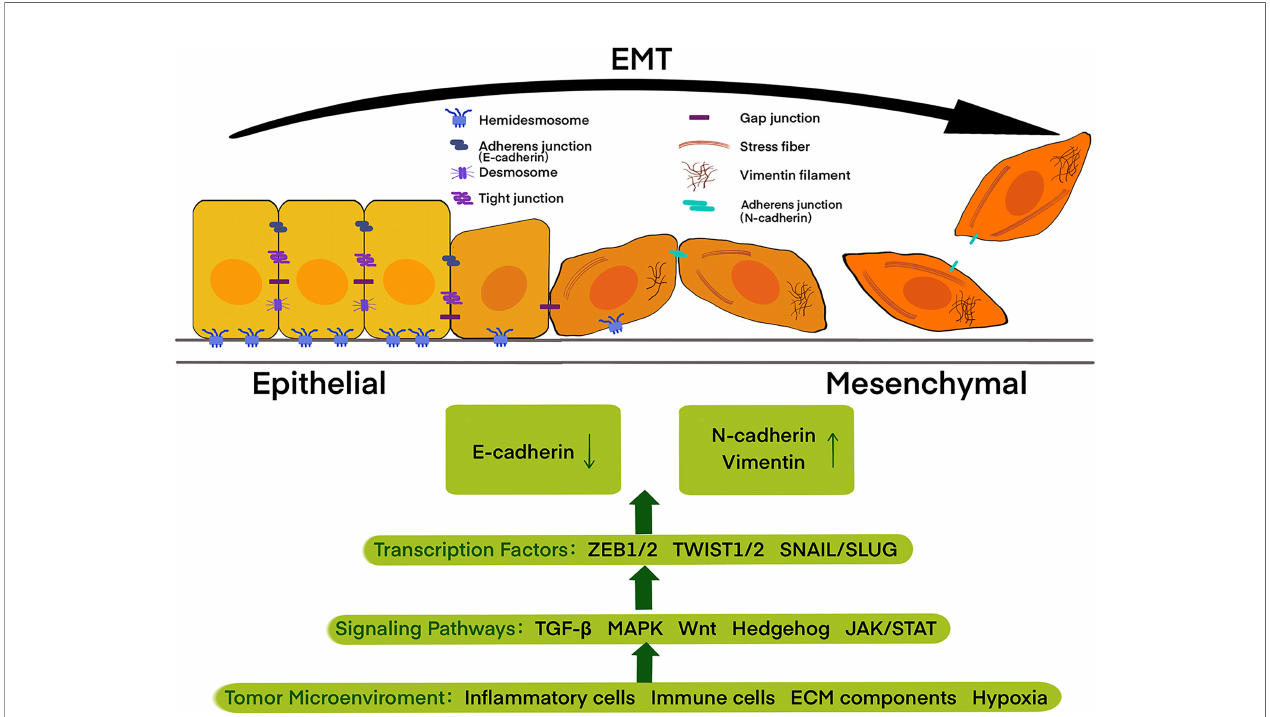
FIGURE 1 | Epithelial cells with apical-basal polarity are tethered to the basement membrane by hemidesmosomes and held together by adherens junctions, tight junctions, and desmosomes, while mesenchymal cells display an extensively reorganized cytoskeleton with front-to-back polarity. Cells during epithelial- mesenchymal transition (EMT) undergo a left to right transition, with the loss of epithelial features accompanied by the acquisition of mesenchymal features. Tumor microenvironment including in fl ammatory cells, immune cells, ECM components, and also physical constraints, such as hypoxia, trigger signaling pathways, including the TGF- b , MAPK, Wnt, Hedgehog, and JAK/STAT, thus activating EMT-promoting transcription factors of the TWIST, SNAIL and ZEB families and further regulate the expression of E-cadherin, N-cadherin, and